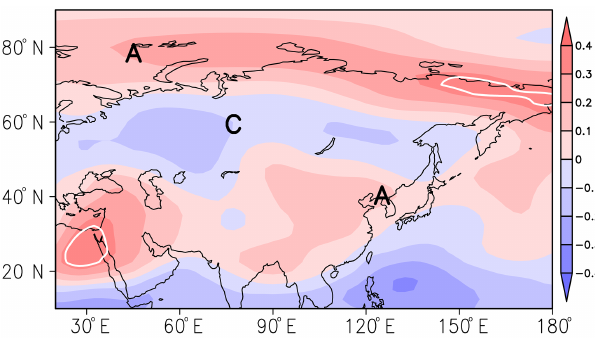
Figure 13. The CC between predictor x 6 and Z500 DY in winter from 1980 to 2013. The white curves indicate that the CC exceeded the 95% confidence level. A and C represent anticyclone and cy- clone, respectively.